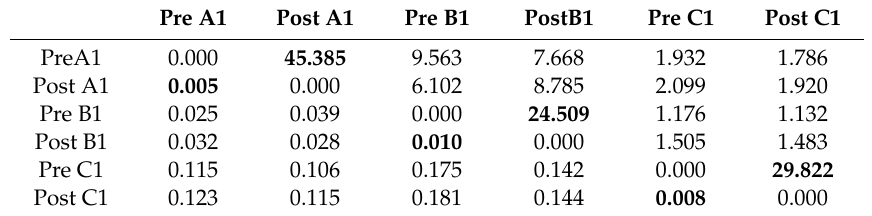
Table 5. Population N M values based on F ST values shown above the diagonal and pairwise F ST values shown below the diagonal for the six Pistacia chinensis